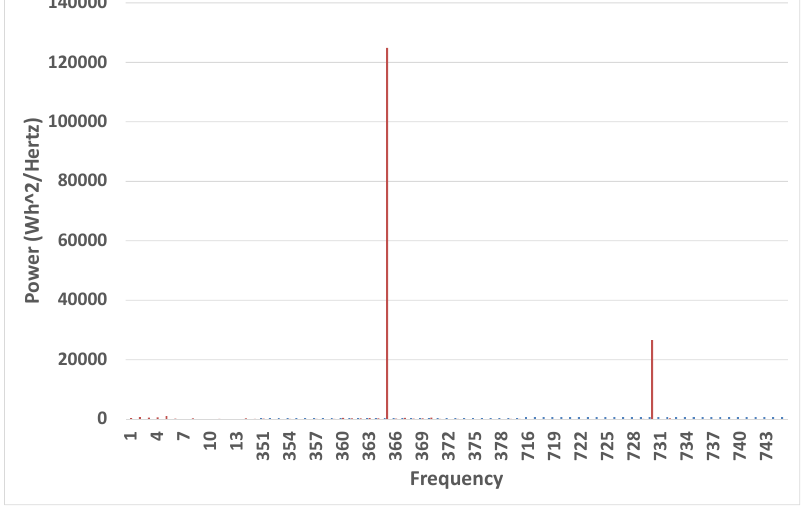
Figure 7. Power spectrum for